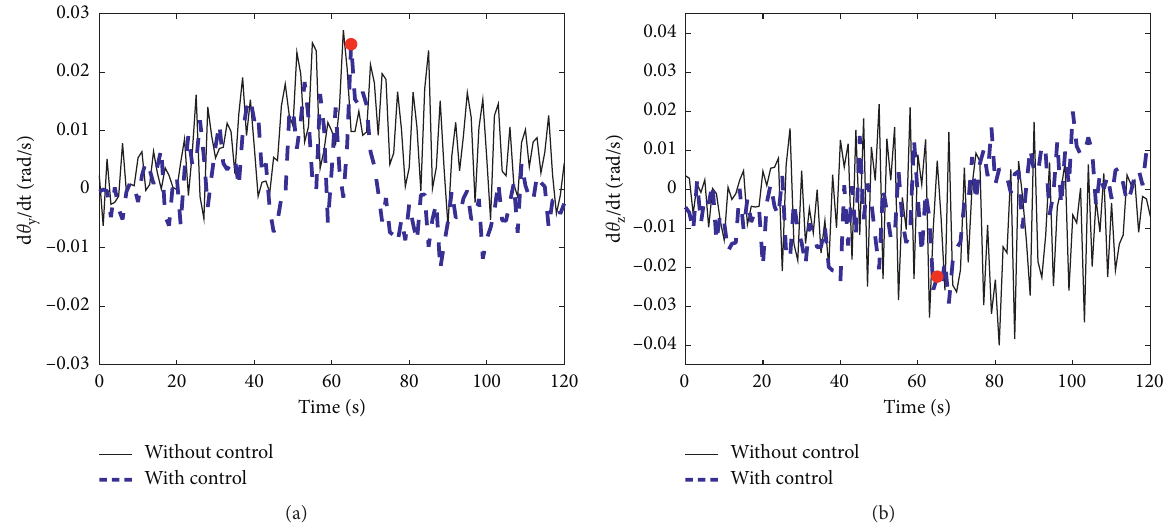
Figure 13: Experimental results of the elevation part in launching process for the 2nd rocket: (a) the yawing angular velocity and (b) the pitching angular velocity. The red dots indicate the action of the